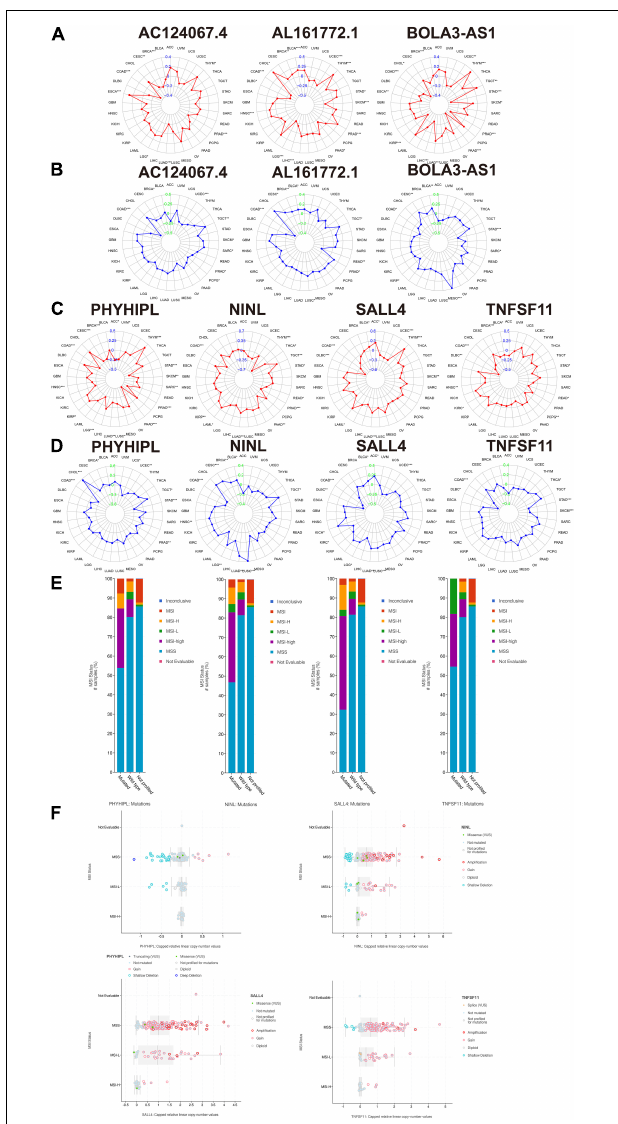
FIGURE 8 | The association between the three lncRNAs ( BOLA3-AS1 , AC124067.4 , and AL161772.1 ), four target mRNAs ( NINL , SALL4 , TNFSF11 , and PHYHIPL ), and the tumor mutational burden (TMB), microsatellite instability (MSI) score, and MSI status. (A) The association between the three lncRNA expression and the TMB in pan-cancer using Spearman’s correlation. (B) The association between the three lncRNA expression and the MSI score in pan-cancer. The association between the four target mRNAs and the TMB (C) and MSI score (D) in pan-cancer. (E) The comparison of the MSI status between the wild type and mutated type of the four target mRNAs (adjusted by each gene mutation rate) in COAD based on cBioPortal. (F) The association between the MSI status and the copy number variation of the four target mRNAs in COAD based on cBioPortal.